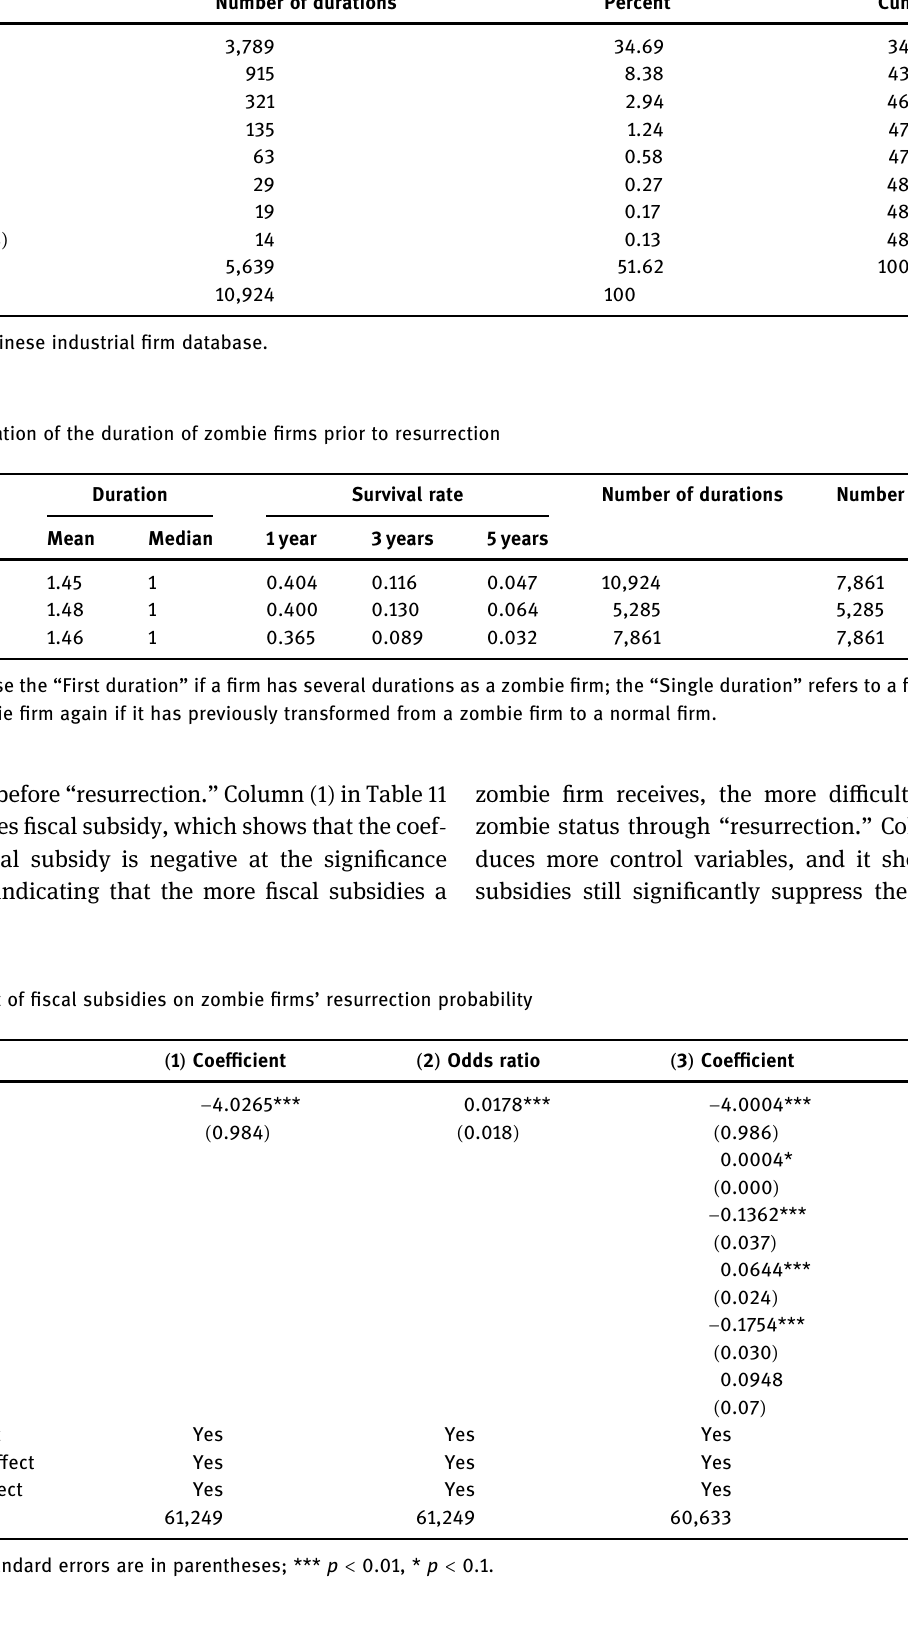
Table 9: Duration distribution of zombie fi rms prior to resurrection Duration Number of durations